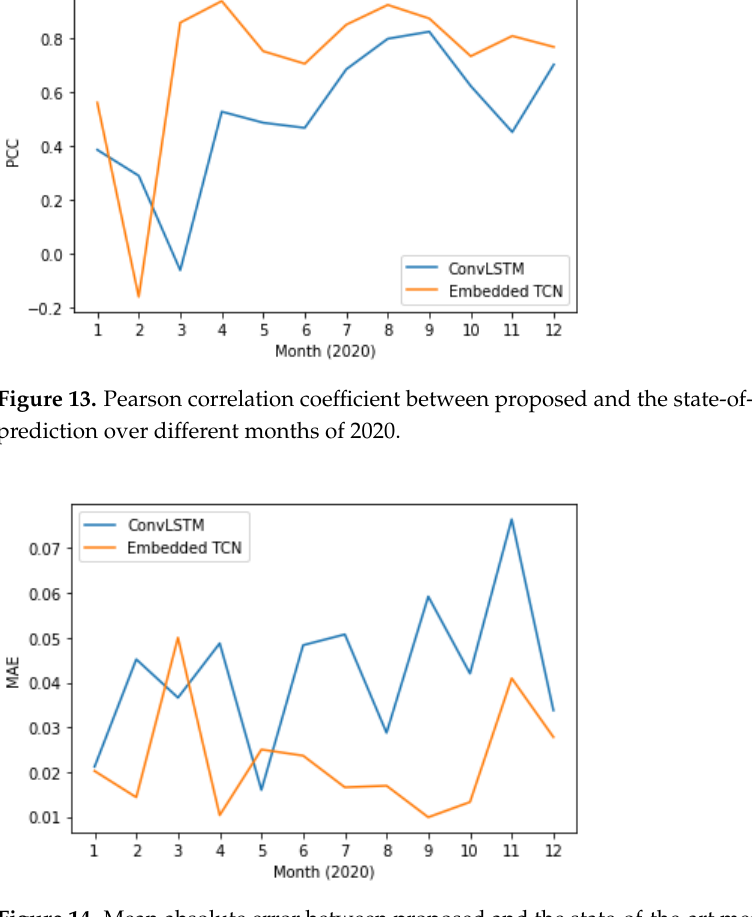
Figure 14. Mean absolute error between proposed and the state-of-the-art method for LST prediction over different months of